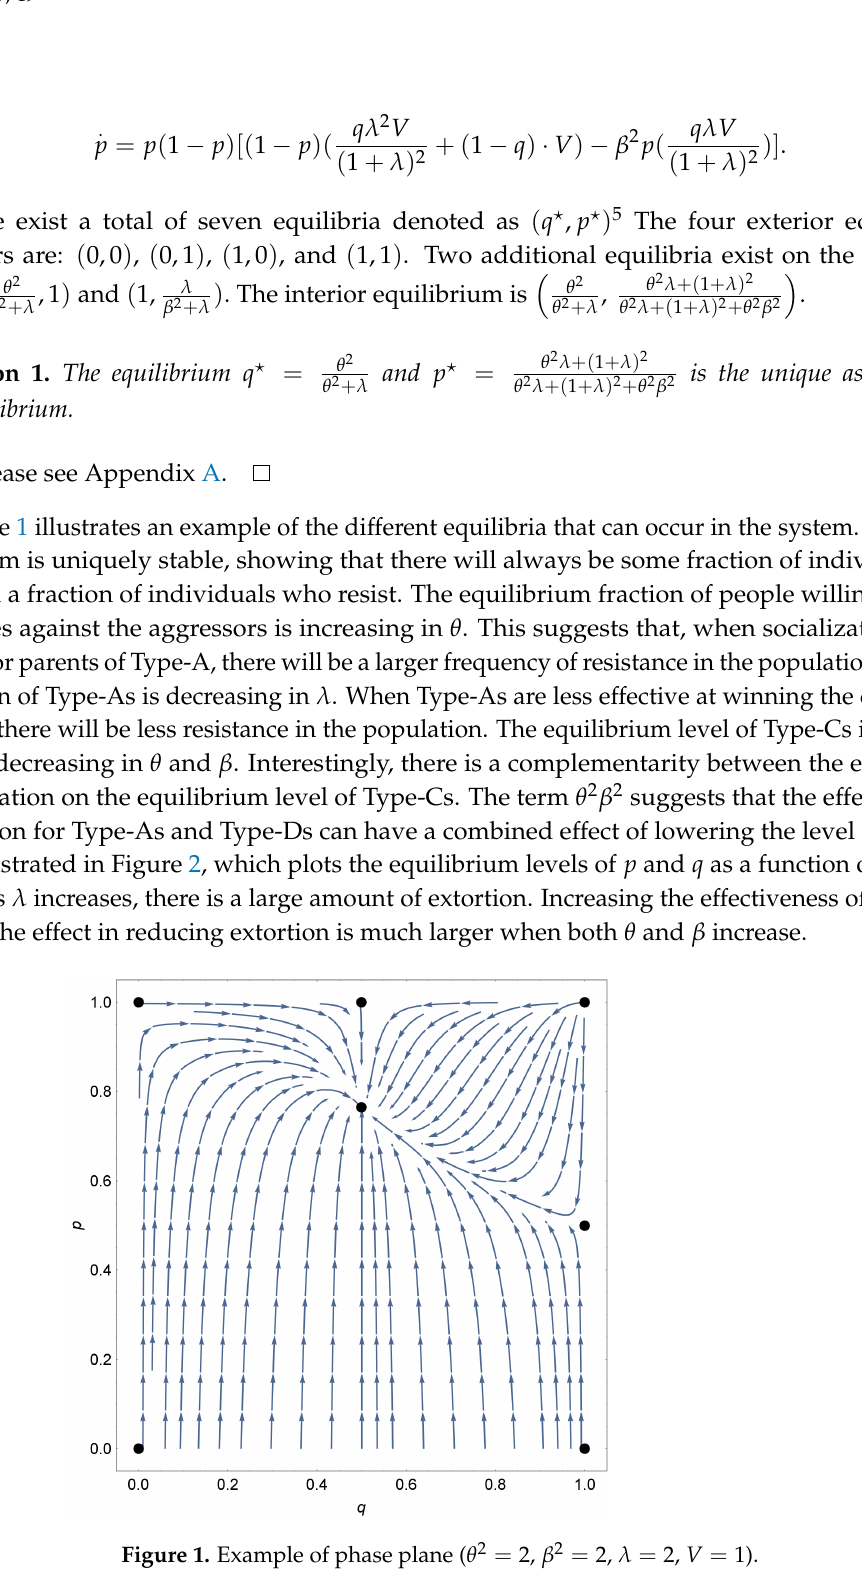
Figure 1. Example of phase plane ( θ 2 = 2, β 2 = 2, λ = 2, V =